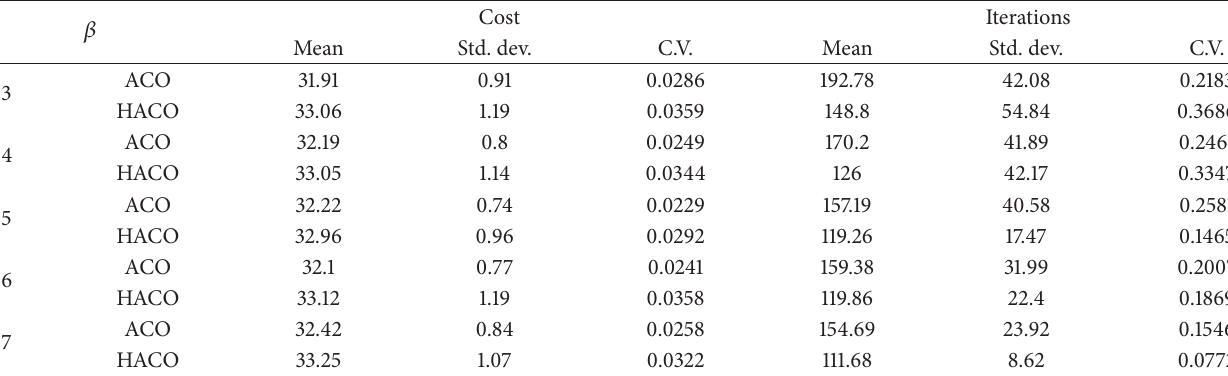
Table 3: Results with different 𝛽 (cost: million CNY; iterations: